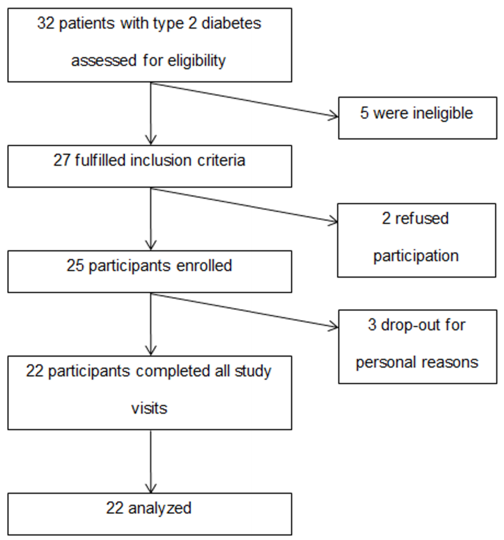
Figure 1. Flow diagram of study